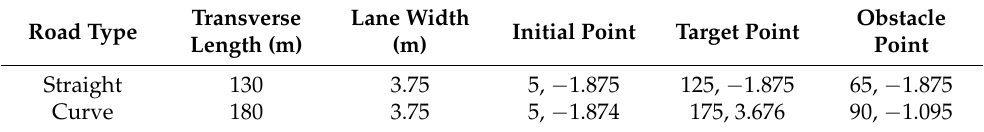
Figure 13. Road scenarios. ( a ) Straight road scenario. ( b ) Curved road scenario. Table 1. Road parameters.